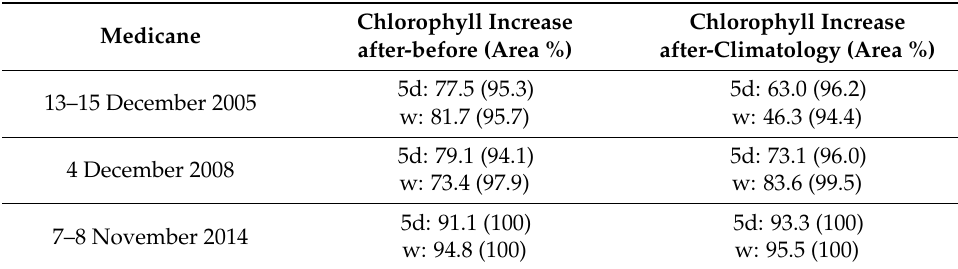
Table 1. Chlorophyll increases in percentages of the affected area for the three medicanes, as revealed by the 5-day (5d) and the weekly (w) chlorophyll data before and after the event. The percentages of absolute chlorophyll differences exceeding 50% that were increases are given in parenthesis.